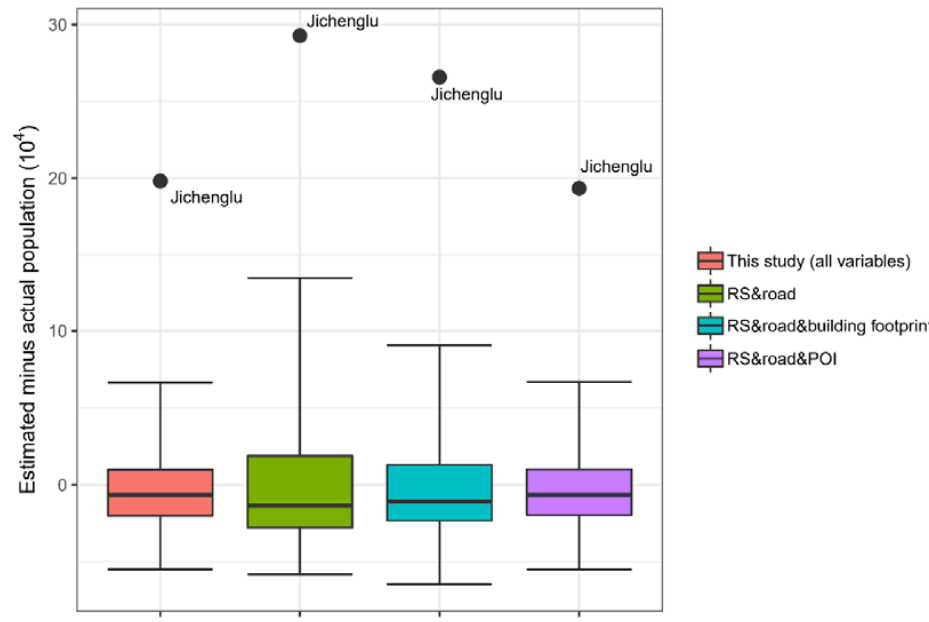
Figure 4. Boxplots of the difference between the estimated and actual population in each jiedao for gridded population datasets generated by di ff erent combinations of variables (i.e., remote sensing and road variables; remote sensing, and road and building footprint variables; remote sensing, and road and point of interest variables; all